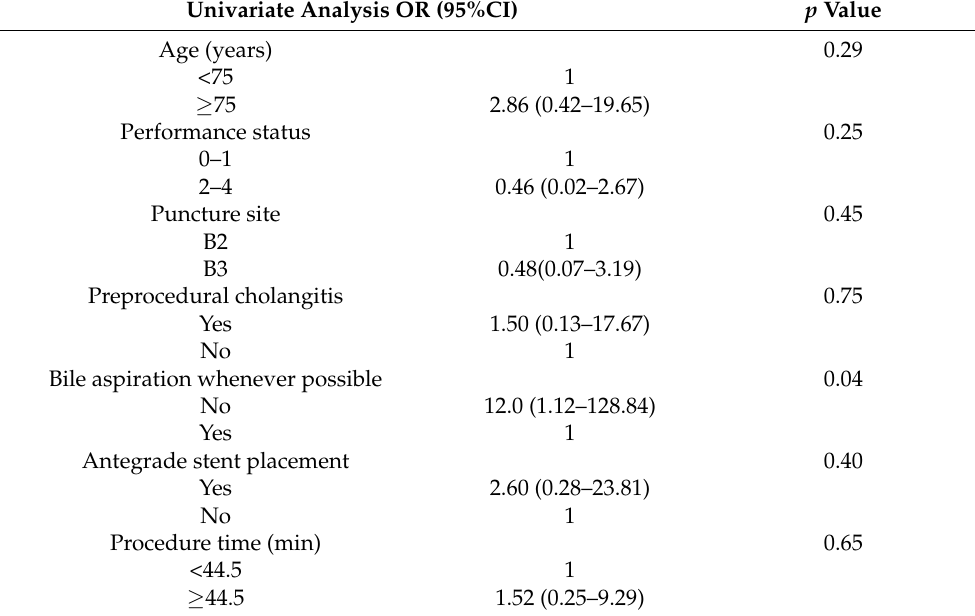
Table 5. Factors affecting adverse